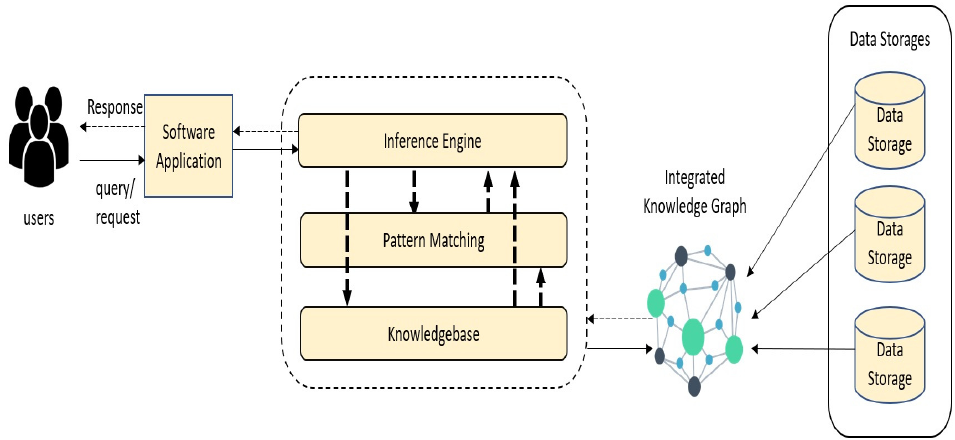
Figure 1. An Intelligent healthcare system.